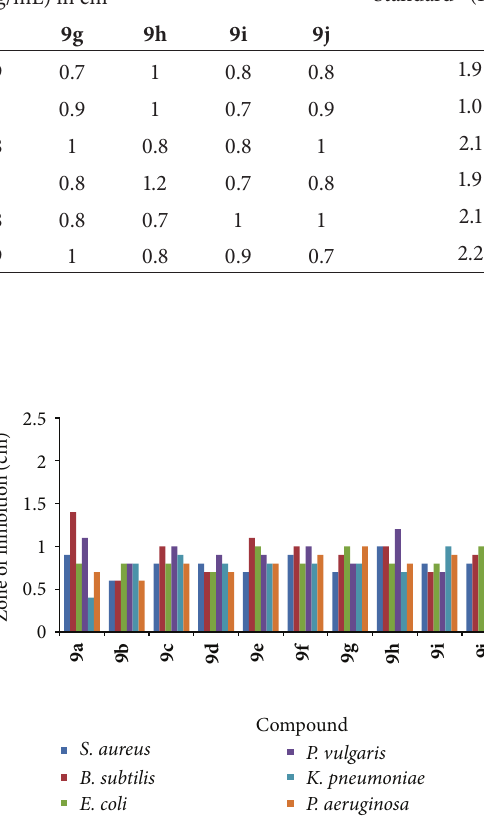
Figure 1: Antibacterial activity of newly synthesized